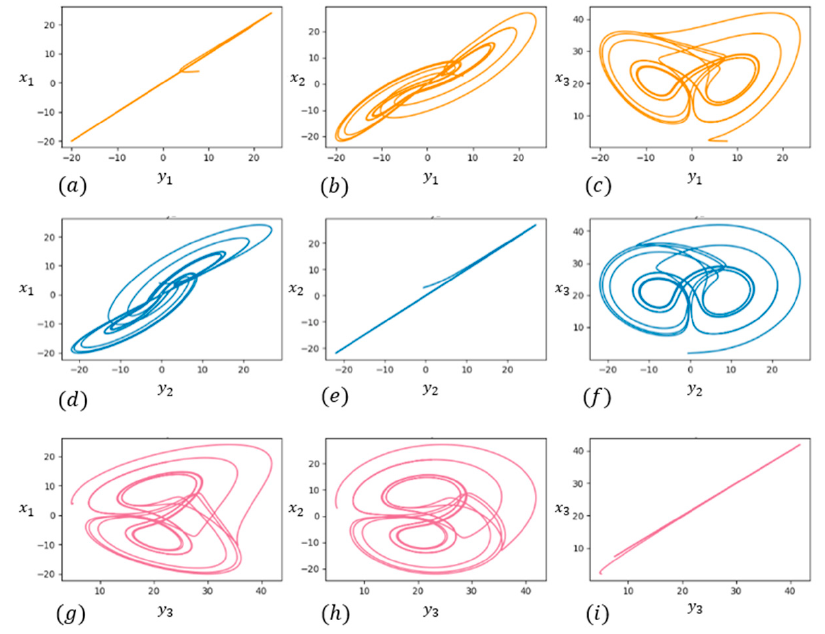
Figure 14. Simulation of the attractors. ( a ) x 1 to y 1 ; ( b ) x 2 to y 1 ; ( c ) x 3 to y 1 ; ( d ) x 1 to y 2 ; ( e ) x 2 to y 2 ; ( f ) x 3 to y 2 ; ( g ) x 1 to y 3 ; ( h ) x 2 to y 3 ; ( i ) x 3 to y 3 .